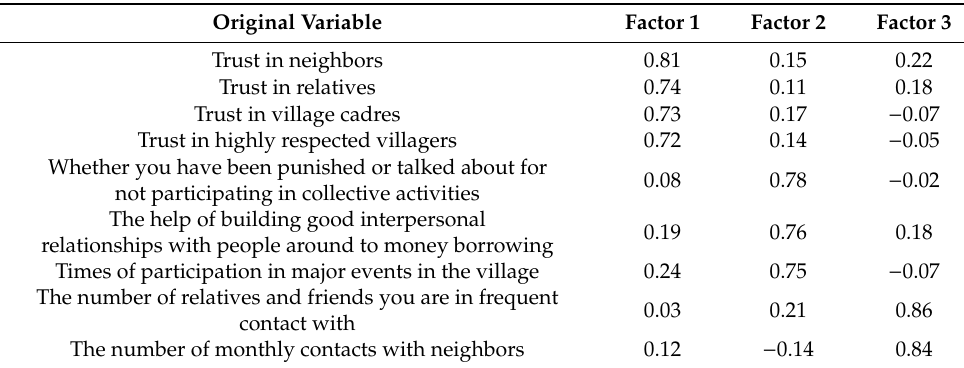
Table 2. Factor load matrix after rotation.